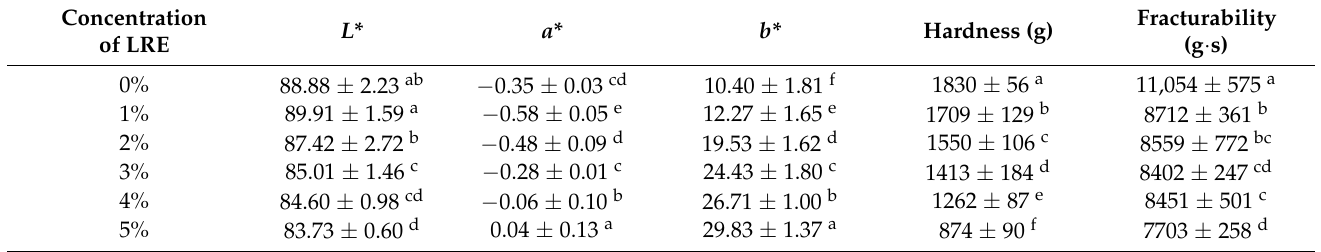
Table 2. Color and texture of biscuits baked from wheat starch gel and LRE in different concentra- tions.